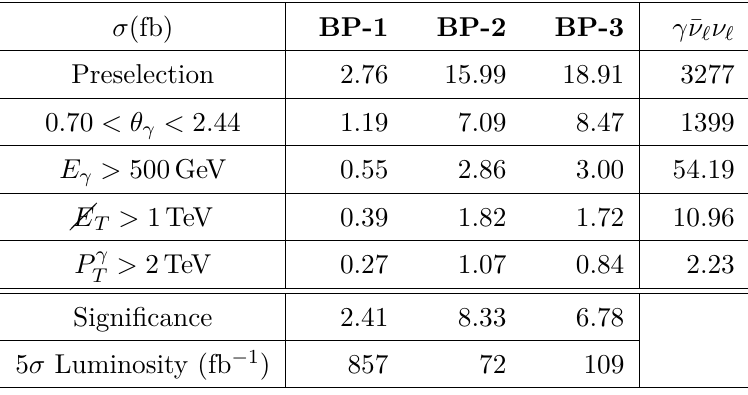
Table 4 . Cut flow table for the mono-photon signature γ + (cid:0) E T from BP-1, BP-2, BP-3 and the dominant background γ ¯ ν ‘ ν ‘